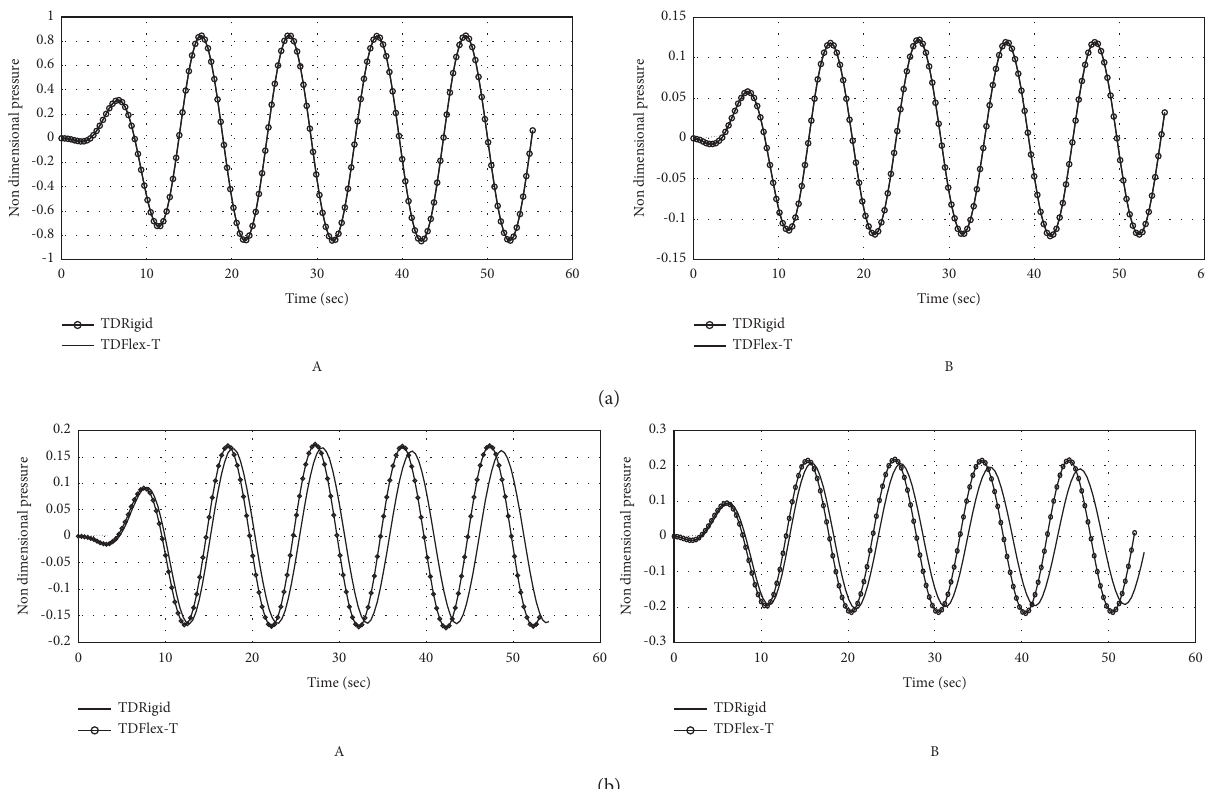
Figure 20: (a) Pressure time history of S175 hull at stern region, F (B) Pressure at bottom surface (Figure 17, location point 6). (b) Pressure time history of S175 hull at stern region, F Pressure at free surface (Figure 17; location point 3). (B) Pressure at bottom surface (Figure 17; location point 6).